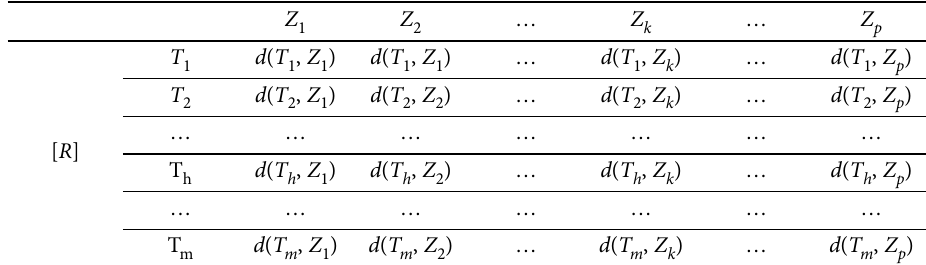
Table 1. Similarity relations between T and